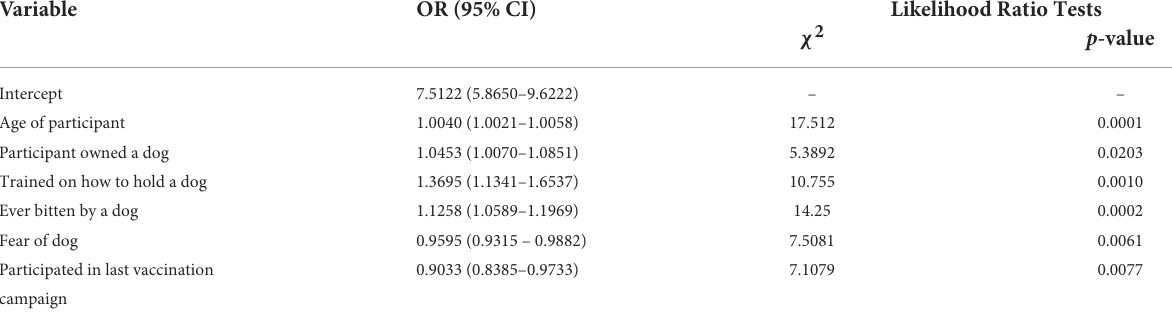
TABLE 2 Participant-related factors that predicted ’knowledge level’ of dog behavior and safe interaction with dogs.